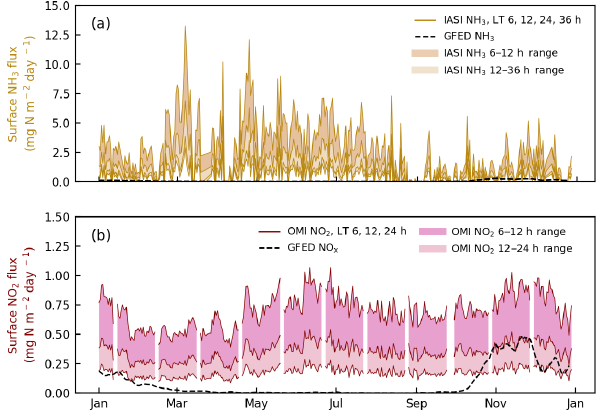
Figure 6. Comparison of daily total surface fluxes and biomass burning emissions of (a) NH 3 -N and (b) NO 2 -N for the focal study region in the Sahel during 2008. Total surface fluxes are estimated from IASI NH 3 and OMI NO 2 observations using a simple box model and assuming effective lifetimes of 6, 12, 24, or 36h for NH 3 and of 6, 12, or 24h for NO 2 . Fire emissions are taken from the GFED4s database. Modeled NO 2 emissions were calculated using values of 0.25 ◦ grid cells within the study region for which NH 3 ob- servations were also present. GFED4s emission means were calcu- lated using 0.25 ◦ grid cells that matched those used in the modeled emissions for the respective gas. Note the difference in scales and that shorter effective lifetimes result in higher modeled